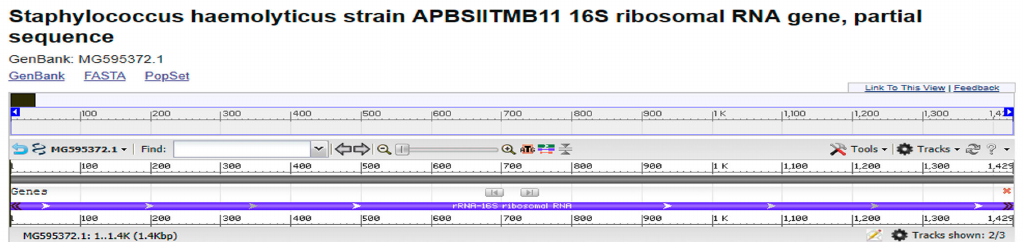
Fig. 1. The exact position of the retrieved 1429 bp amplicon that partially covered a portion of 16S rRNA locus of Staphylococcus haemolyticus genomic DNA sequences (GenBank acc no.